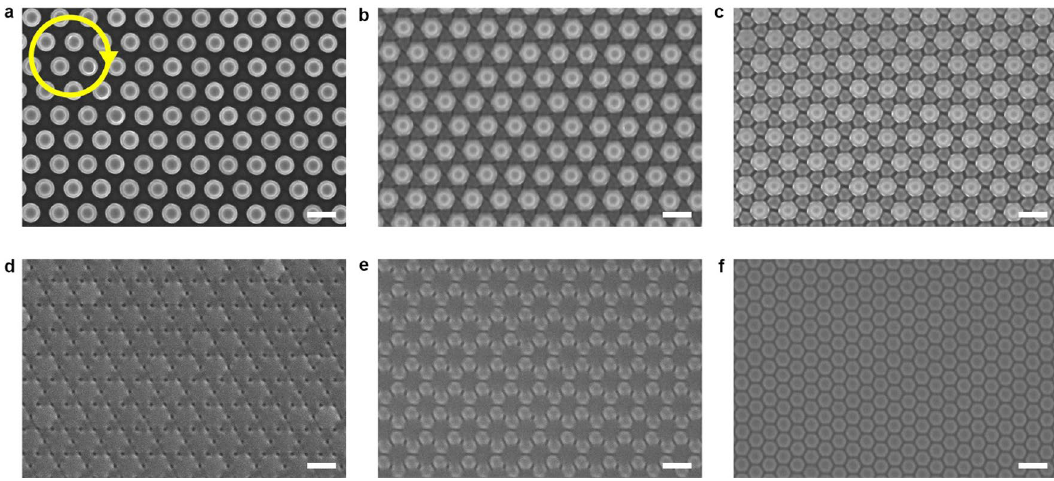
Figure 2. Typical top view SEM images of the IA-Chol submicron pillar arrays after being exposed to the right- hand circularly polarized light for different time periods. ( a ) 4 min. ( b ) 6 min. ( c ) 8 min. ( d ) 10 min. ( e ) 14 min. ( f ) 30 min. The yellow circular arrow represents the electric field vector pattern in the X–Y plane. The light intensity was 300 mW cm −2 . The scale bars of all the SEM images correspond to 1